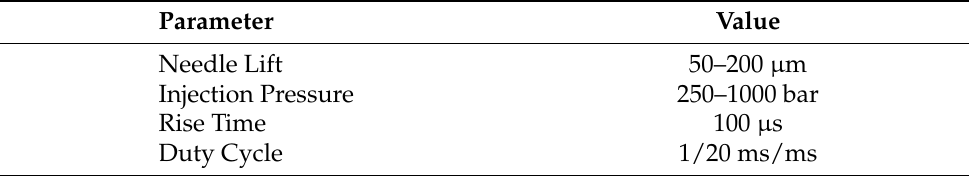
Table 1. Design parameters of the magnetostrictive